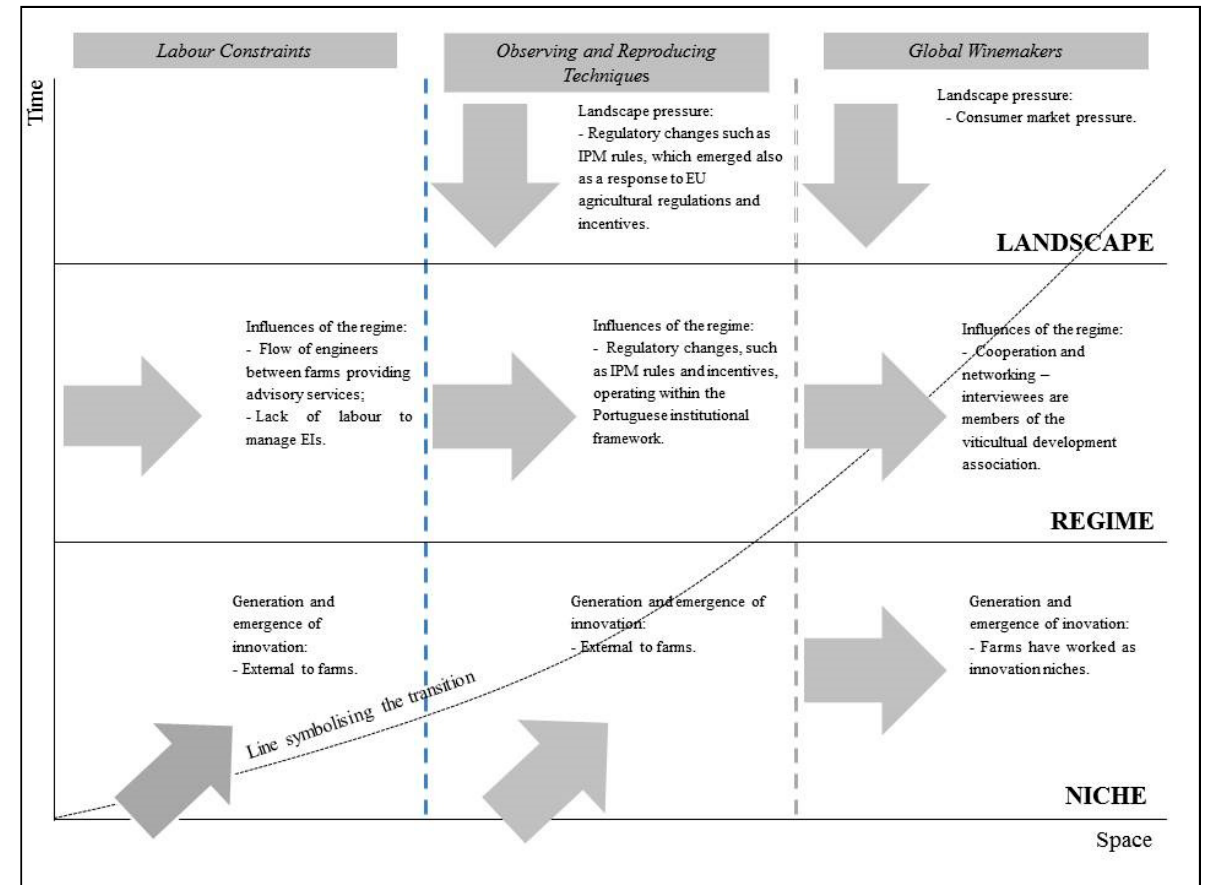
Figure 3. Representation of the overlapping of niche, regime, and landscape influence, creating different trajectories of adopting innovation and an ongoing transition. Source: Adapted from Geels [14] and created from data gathered in the course of the present research.